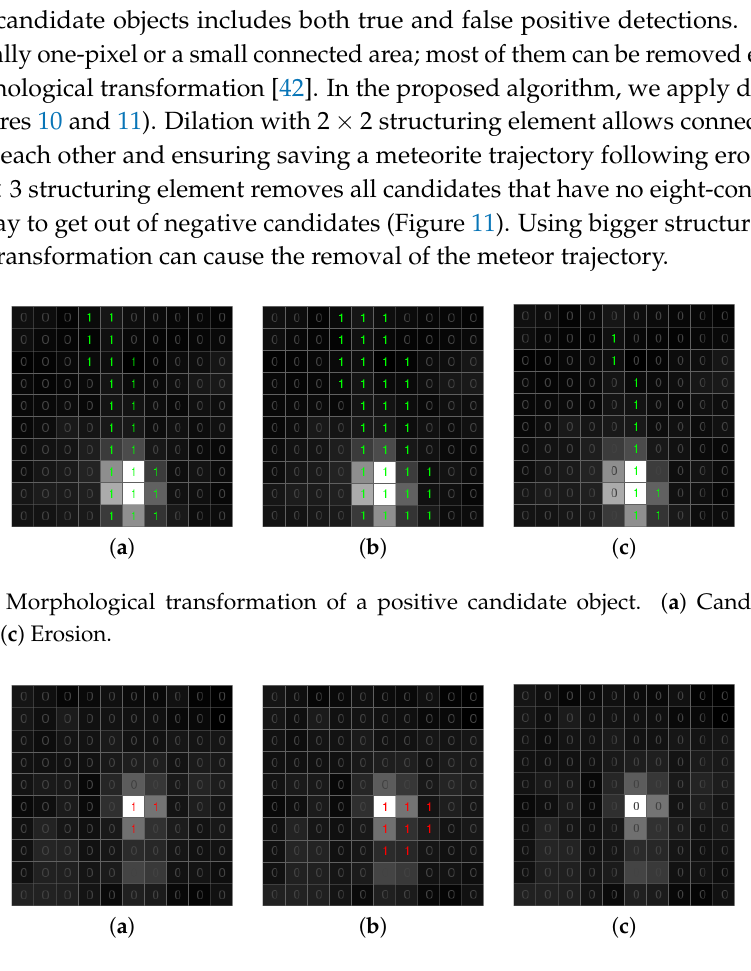
Figure 11. Morphological transformation of a negative candidate object. ( a ) Candidate object. ( b ) Dilation. ( c )